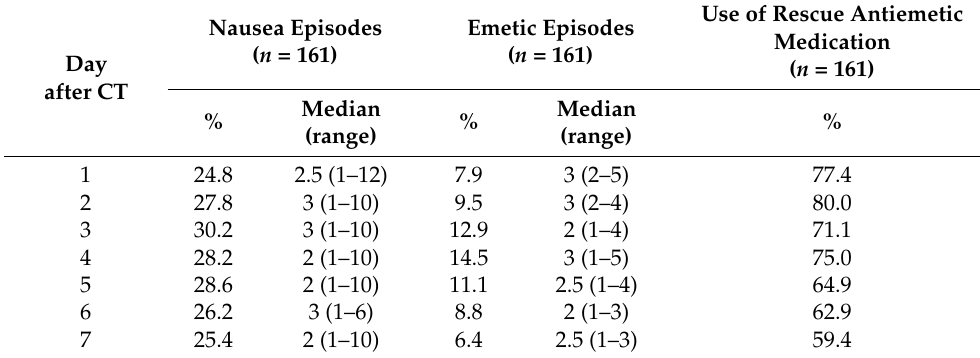
Table 4. Nausea and emesis episodes characterisation.